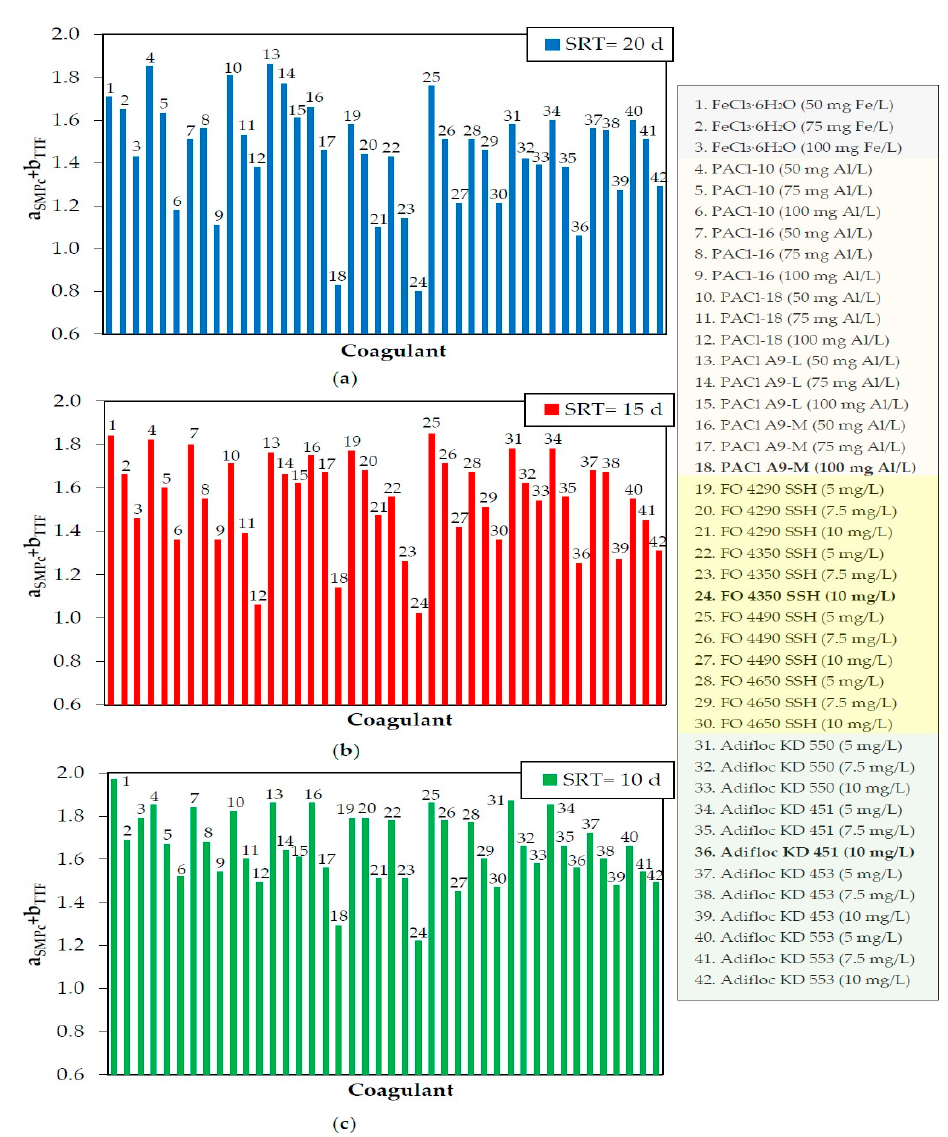
Figure 2. Sum a SMPc + b TTF after the batch-mode addition of coagulants for ( a ) solids retention time (SRT) = 20 d, ( b ) SRT = 15 d, or ( c ) SRT = 10 d. SMP, soluble microbial product; TTF, time-to-filter.